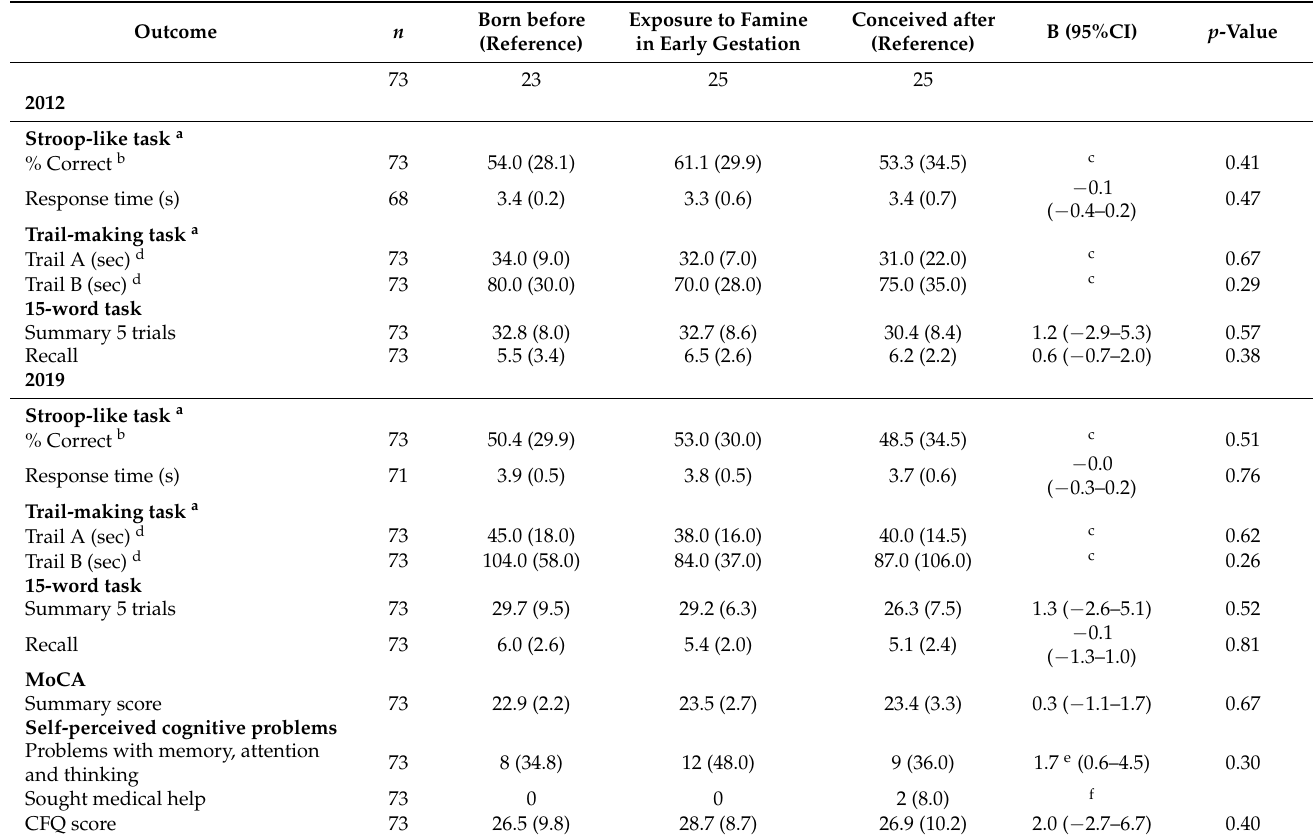
Table 2. Associations between prenatal exposure to famine and cognitive outcomes compared with individuals born before or conceived after the famine around age 68 (2012) and 74 (2019).